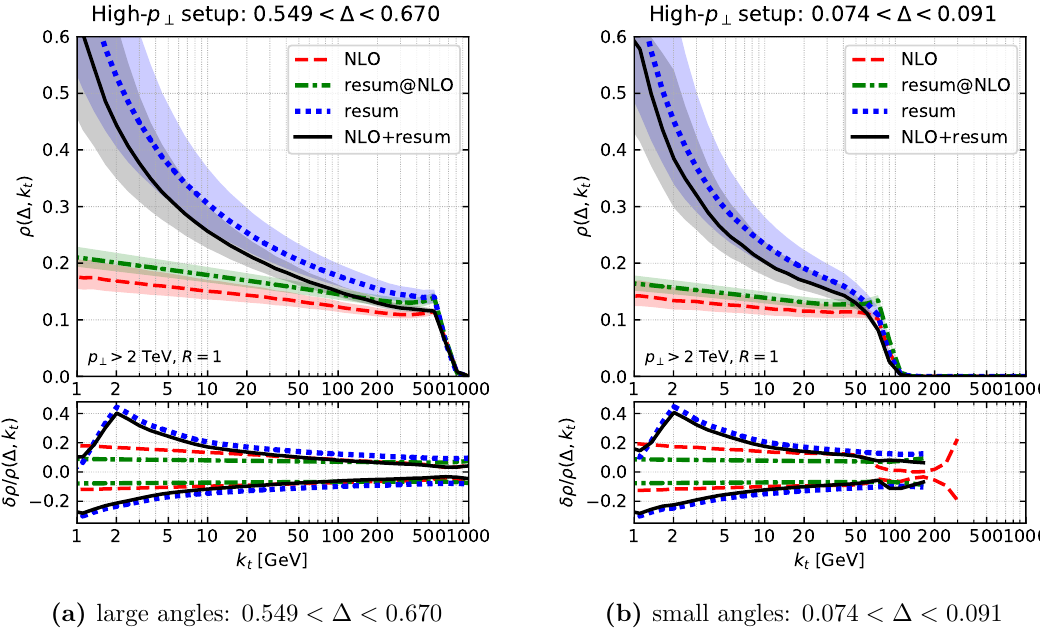
Figure 8. Slices of the primary Lund-plane density (cid:26) ((cid:1) ; k t ) at constant (cid:1). The upper panels correspond to the density (cid:26) ((cid:1) ; k t ) itself, while the lower panels show the relative scale uncertainties (cid:14)(cid:26) ((cid:1) ; k t ). We show results for the exact NLO calculation (red), the NLO expansion of the resummed (cid:26) results (green), the full resummed result (blue) and the NLO+resummation matched result